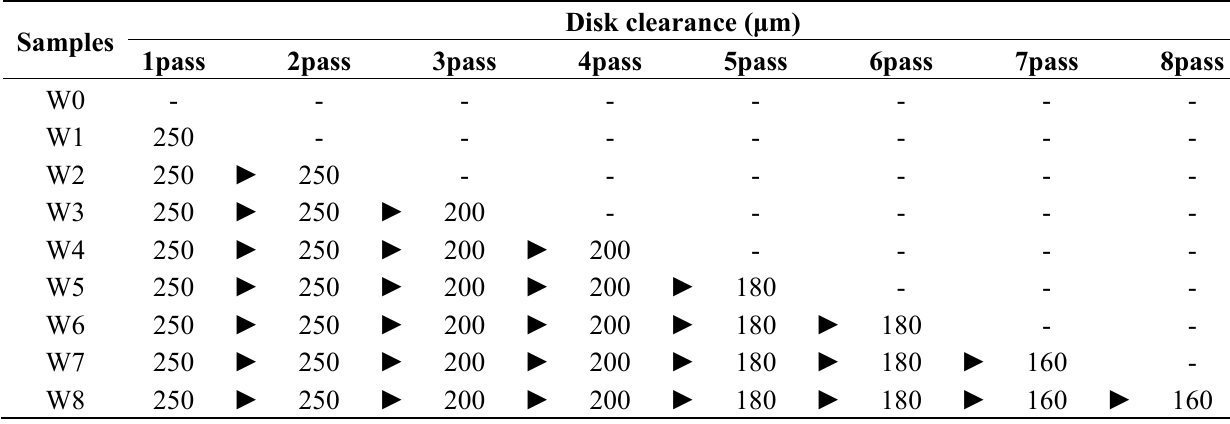
Table 1. Pulverizing conditions and disk mill